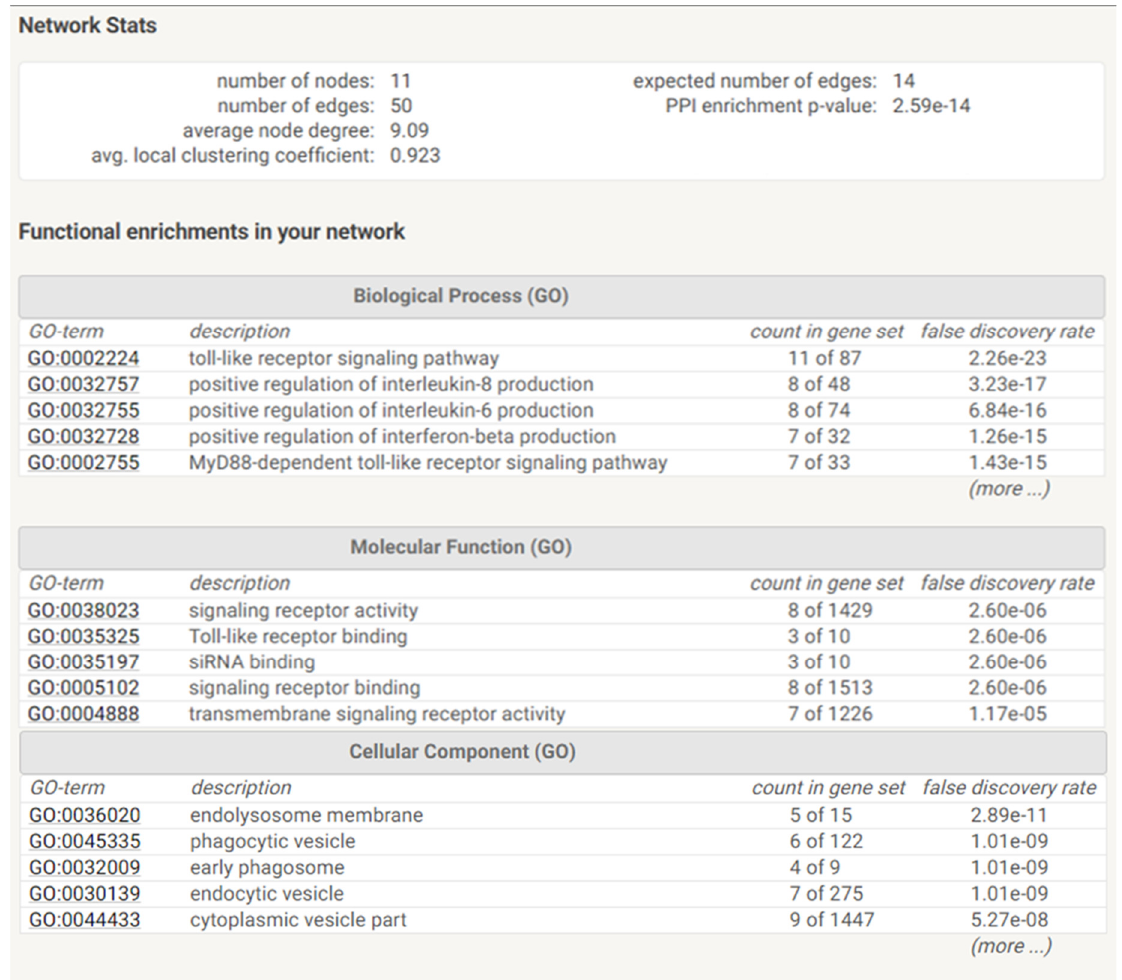
Figure 8. Functional enrichments and Statistics of TLR networks interactions and association. Gene Ontology (GO) is used to perform enrichment analysis for biological process, molecular functions and cellular components.